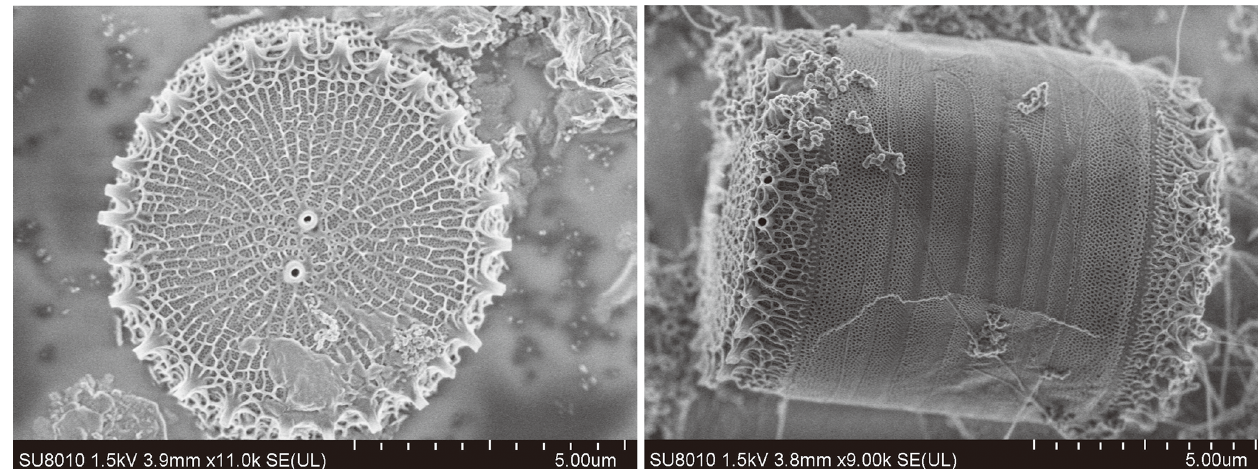
Figure 2. Scanning electron microscopy (SEM) images of T. weissflogii .